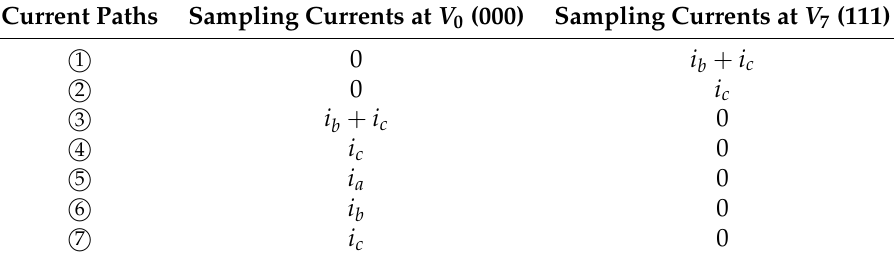
Table 1. Sampling currents of seven current paths during the two zero voltage